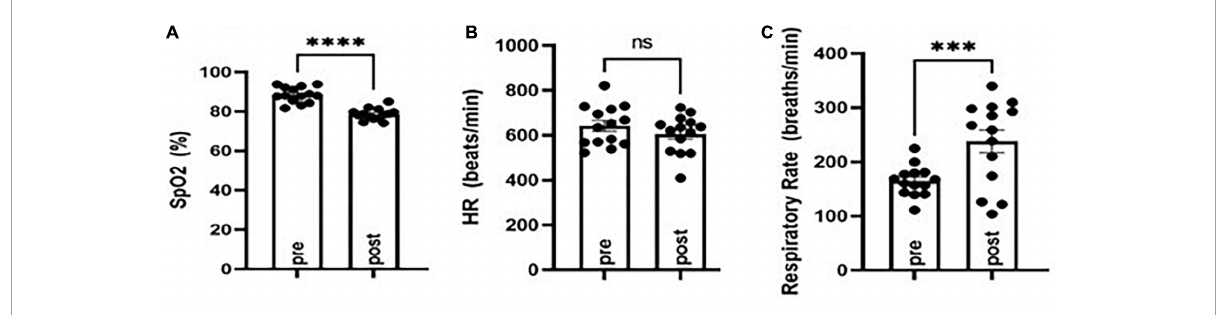
FIGURE1 Evaluation of oxygen saturation (SpO 2 ), respiratory rate, and heart rate before (pre) and following (post) MES-induced tonic extension in CF-1 mice. SpO 2 was diminished (A) concomitant with an increased respiratory rate (B) and no major changes in heart rate (C) . ∗∗∗ P < 0.001, ∗∗∗∗ P < 0.0001 compared to pre, Student’s t -test. N = 14.